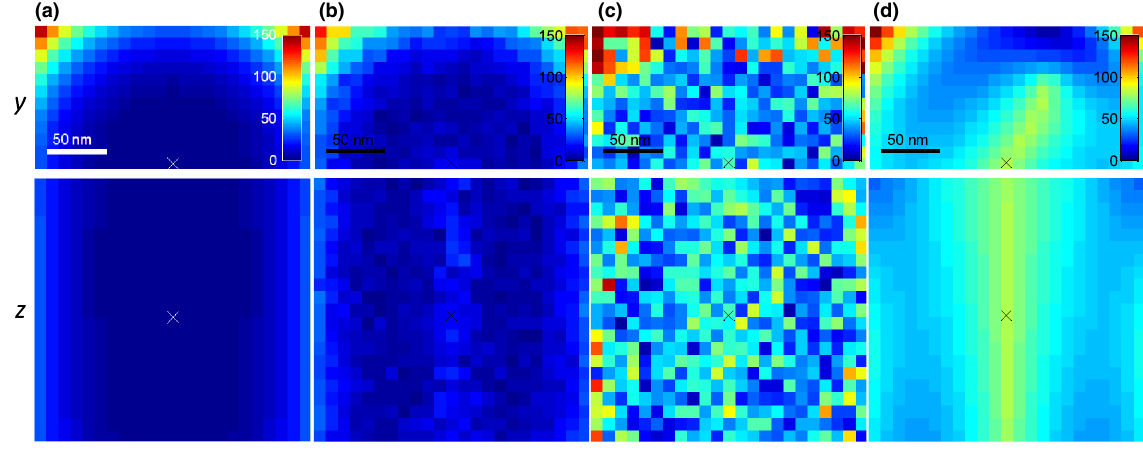
FIG. 5. Position localization precision. Difference between the set position of the nanoparticle in 3D and the deduced position using the FWM field amplitude and phase with the coordinate reconstruction parameters as described in the text. The color bar gives the values of this difference in nanometers. The top panels show maps in the ð x; y Þ plane, and the bottom panels are axial ð x; z Þ maps. The cross shows the position of the focus center. (a) Spherical particle without shot noise. (b) Spherical particle with relative shot noise of 0.07% as in the experiment in Fig. 4. (c) Spherical particle with relative shot noise of 0.7%. (d) Asymmetric particle with semi-axis a ¼ 30 . 135 nm and b ¼ c ¼ 30 nm, as in the simulations in Fig.